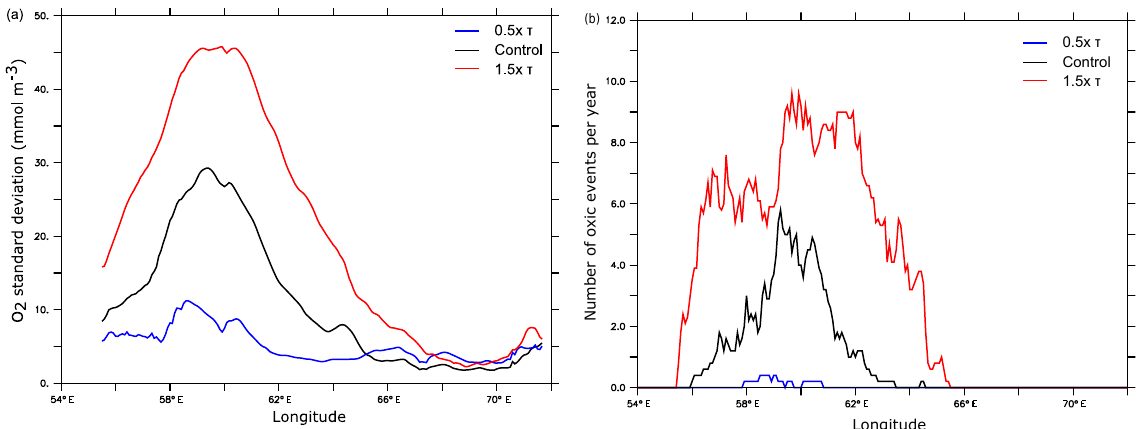
Figure 11. Oxygen variability as a function of monsoon wind intensity. (a) Oxygen temporal standard deviation (in mmolm − 3 ) and (b) num- ber of episodic oxic events (O 2 > 60mmolm − 3 ) per year along 17.5 ◦ N at 150m (corresponding to the depth of the upper OMZ peak) as simulated under different monsoon wind intensities.